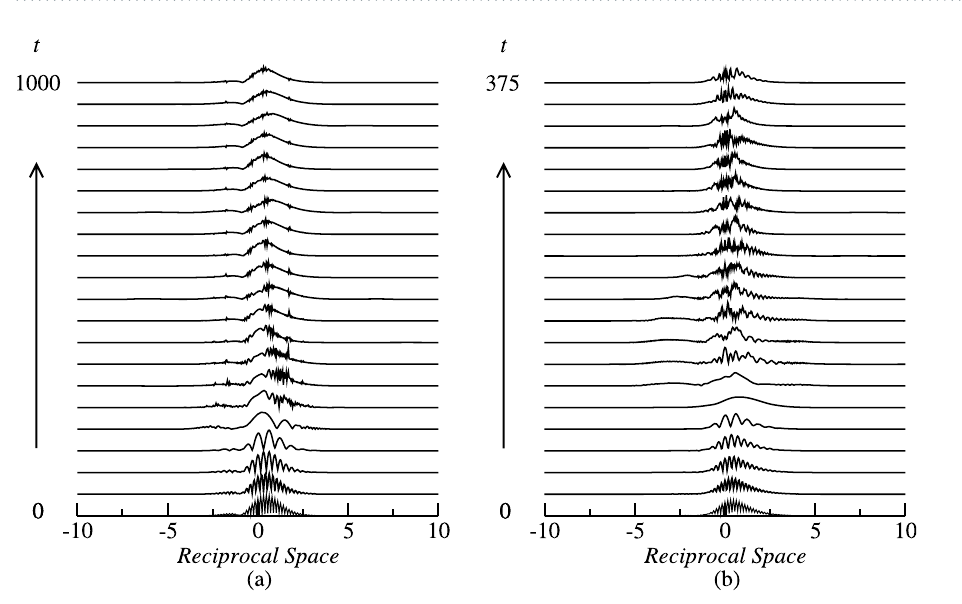
Figure 8. The amplitude spectrum of the collisions corresponding to ( a ) Fig. 7(e) and ( b ) Fig. 7(a). Only the spectrum for the u -component is